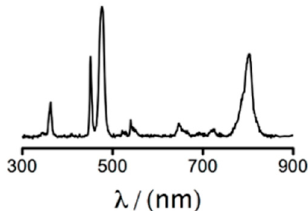
Figure 8. Fluorescence emission spectrum for UCNPs doped with several lanthanides after excitation with CW laser at 980 nm [139]. Multiple emission peaks can be observed at 360 nm, 451 nm, 476 nm and 800 nm.